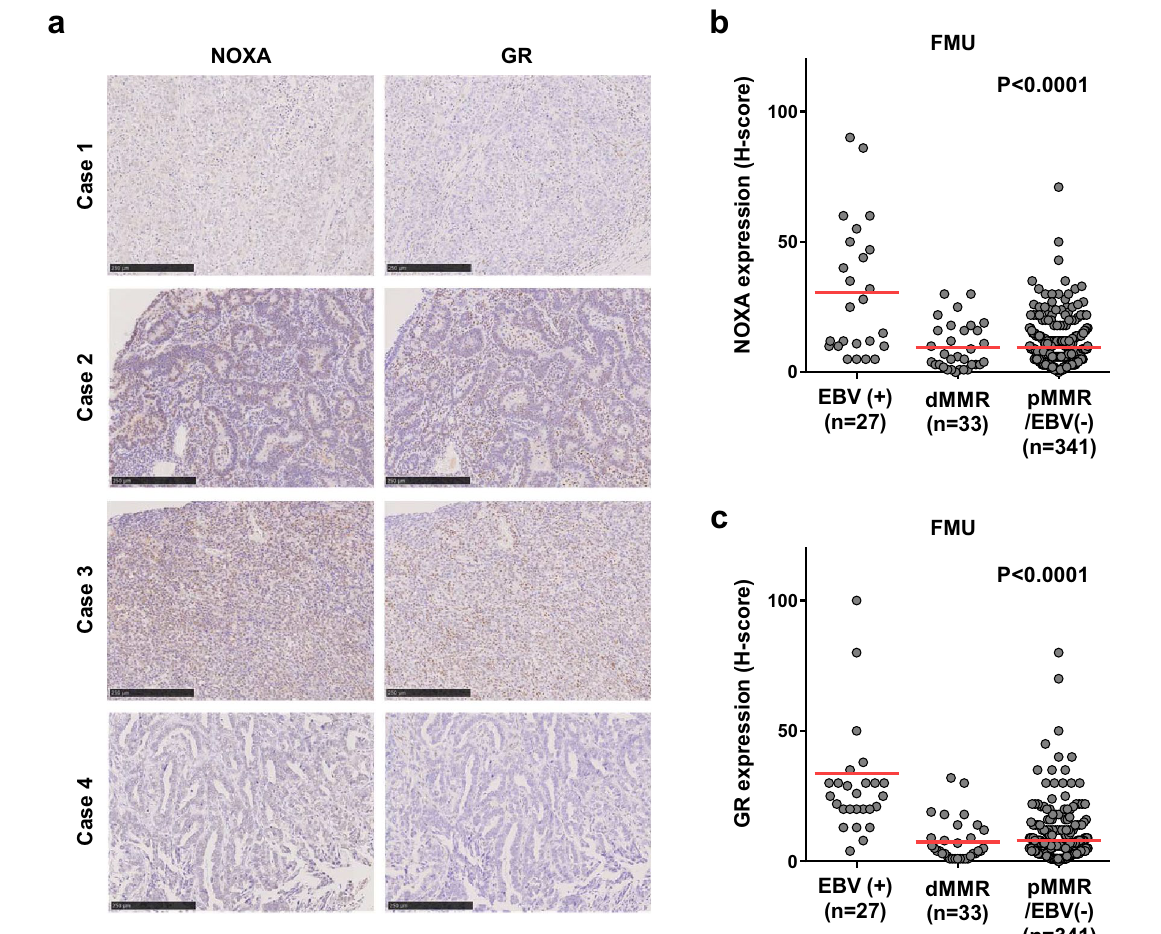
Figure 4. Differential expression of IRF3 signature genes among EBV (+), dMMR, and pMMR/EBV (−) gastric cancer (GC) samples from FMU cohort. (a) Representative images showing IHC staining for NOXA in Case 1 (H-score = 10), 2 (H-score = 60), 3 (H-score = 35), and 4 (H-score = 1), and GR in Case 1 (H-score = 25), 2 (H-score = 160), 3 (H-score = 70), and 4 (H-score = 6). Case number is showing the same case as in Fig. 1a,b. Scale bars = 250 μm. (b) NOXA was expressed more strongly in EBV (+) than in dMMR or pMMR/EBV (−) GC in the FMU cohort (P < 0.0001). (c) GR was expressed more strongly in EBV (+) than in dMMR or pMMR/EBV (−) GC in the FMU cohort (P <